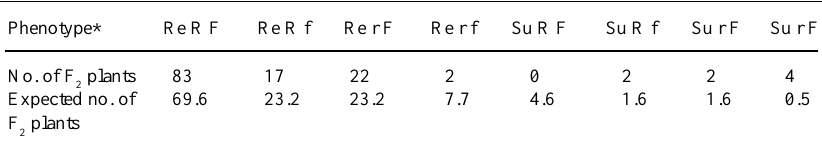
Table V - Observed and expected numbers of F bean plants assuming independent distribution of the 2 fungus reaction and of the bands generated by the primers OPF10 and OPR03.